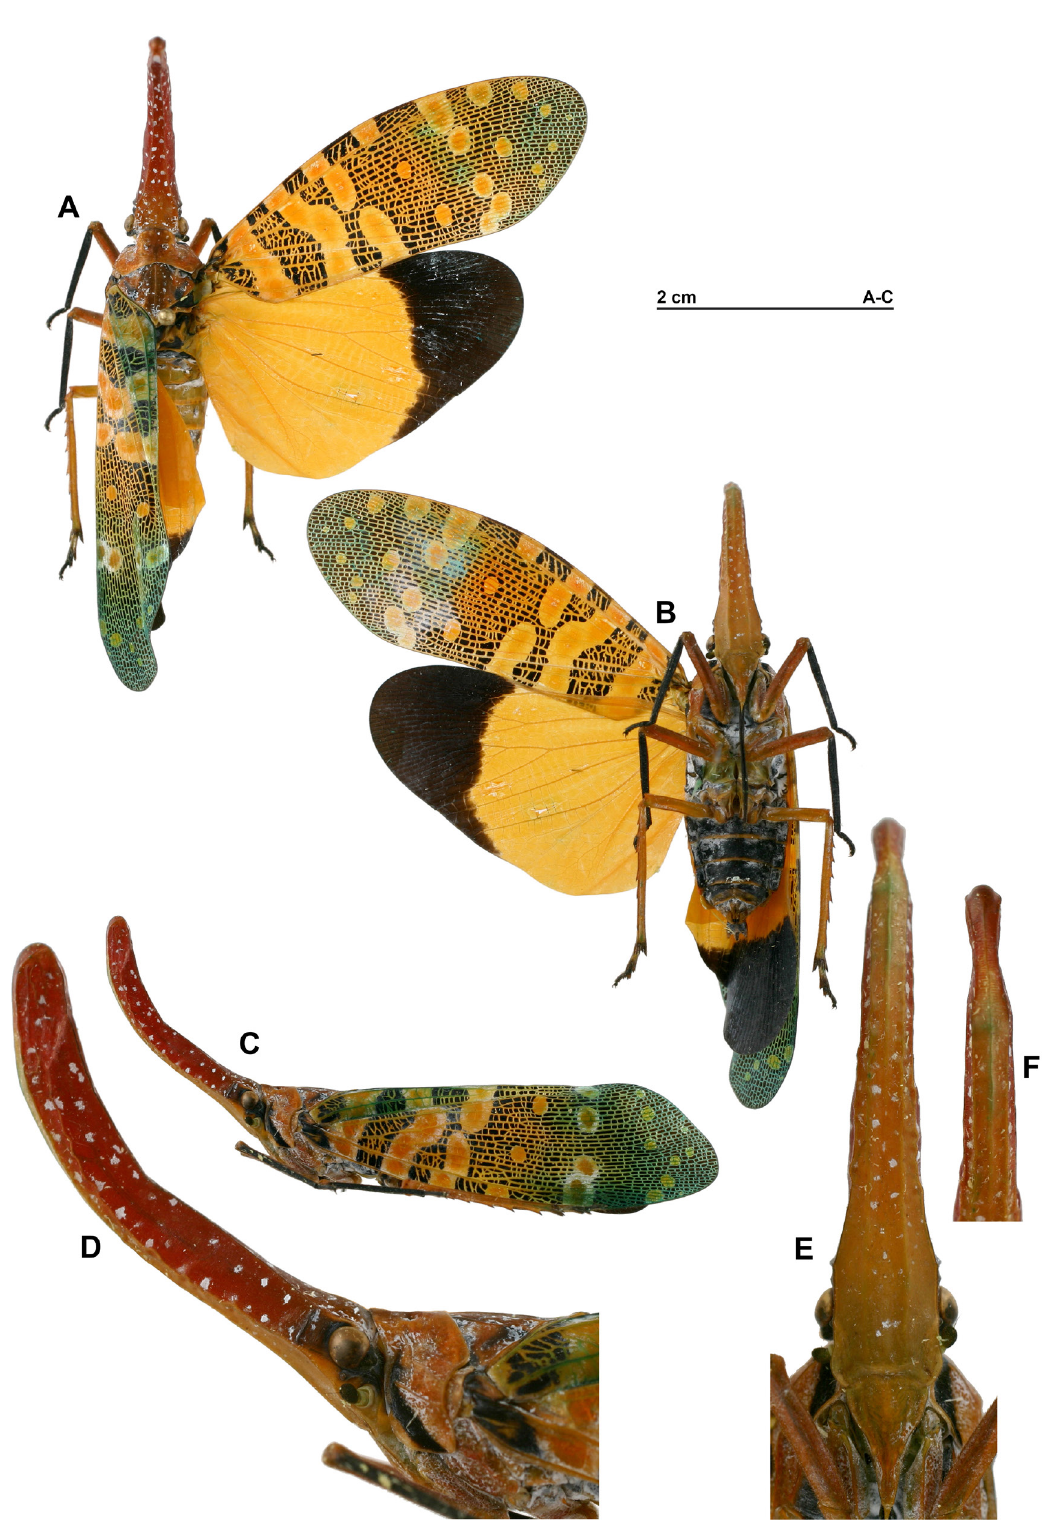
Fig. 16. Pyrops candelaria (Linné, 1758), ♀, Vietnam, Vinh Phuc Prov., Me Linh Biodiversity Station, 20–24 Aug. 2010 (RBINS). A . Habitus, dorsal view. B . Habitus, ventral view. C . Habitus, lateral view. D . Head and thorax, lateral view. E . Head, perpendicular view of frons. F . Apex of cephalic process, anteroventral view. D–F = not to